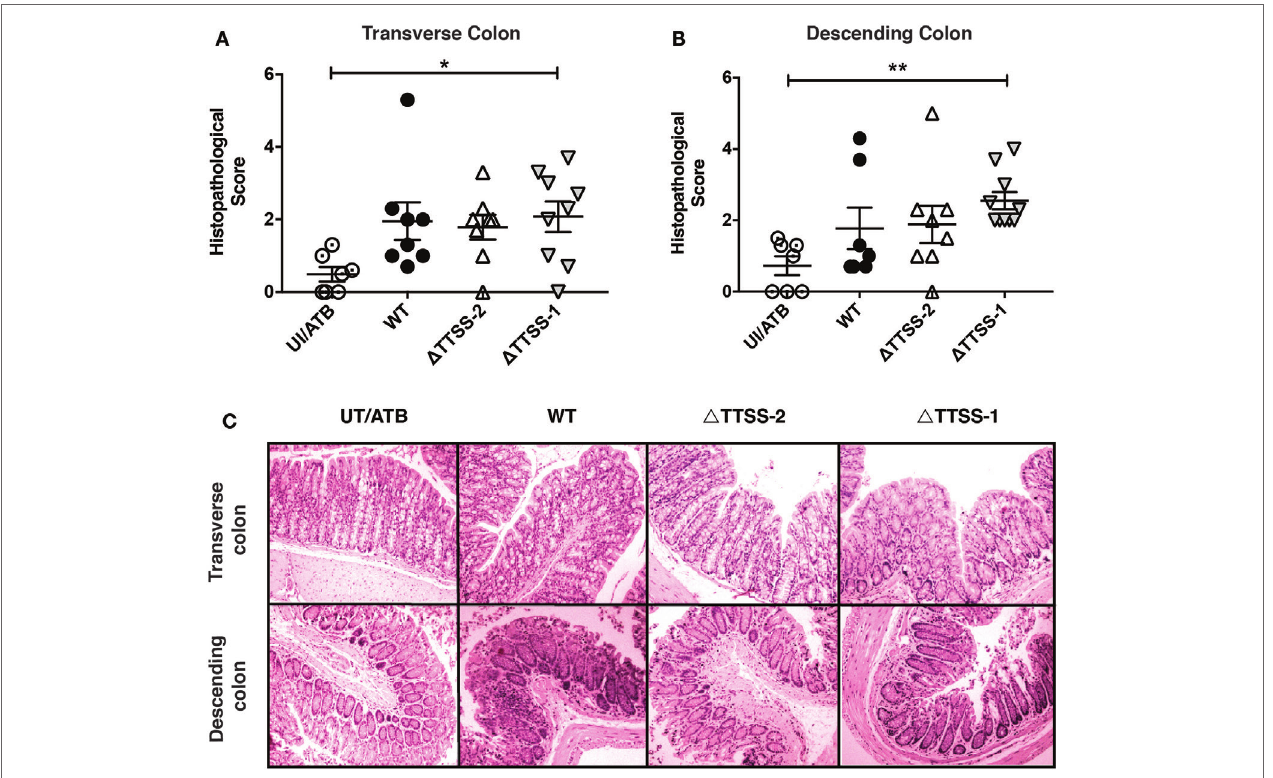
FigUre 3 | Previous Salmonella enterica serovar Typhimurium ( S. Typhimurium) infection increases the susceptibility of spontaneous inflammation of colon of interleukin (IL)-10 − / − mice in a 2-encoded type three secretion system (TTSS-2)-dependent fashion. Average histopathology score for (a) transverse colon and (B) descending colon of 6–10 IL-10 − / − mice included in each group. (c) Representative images of the intestines of IL-10 − / − mice infected with S. Typhimurium wild type (WT), Δ TTSS-1, or Δ TTSS-2 (4 µm transverse and descending colon sections stained with H&E and observed in optical microscope at 10 × magnification). Data shown are mean ± SEM of three independent experiment with 8 mice uninfected; 10 mice infected with WT strain; 10 mice infected with Δ TTSS-1 strain; and 9 mice infected with Δ TTSS-2 strain. Histopathology score was analyzed by one-way ANOVA with Kruskal–Wallis post-test. Data shown are mean ± SEM * P < 0.05; compared with uninfected mice. Tissue damage and inflammatory infiltration are indicated (arrow).